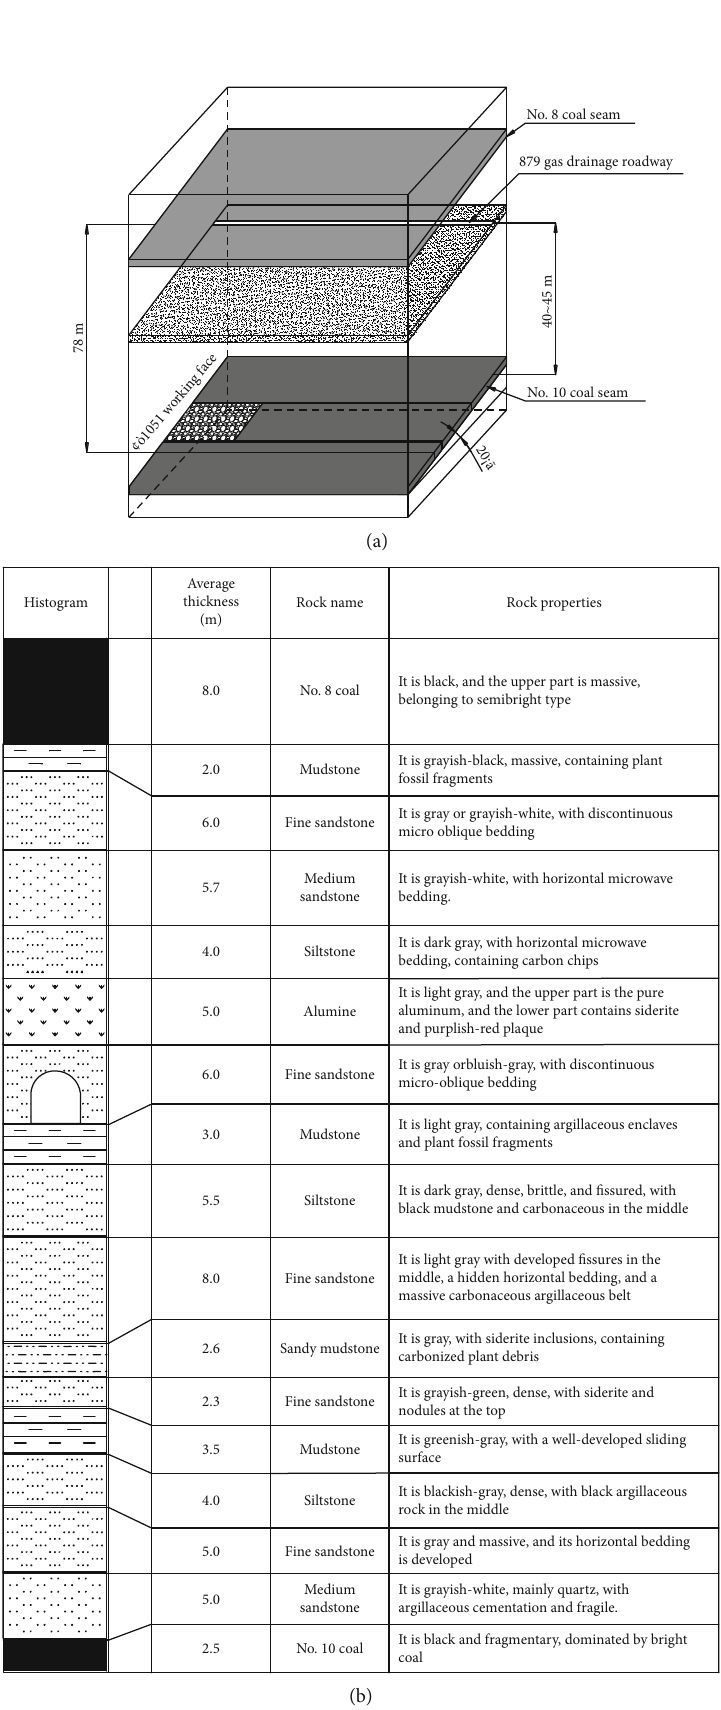
Figure 1: Comprehensive histogram depicting the spatial location and geology of